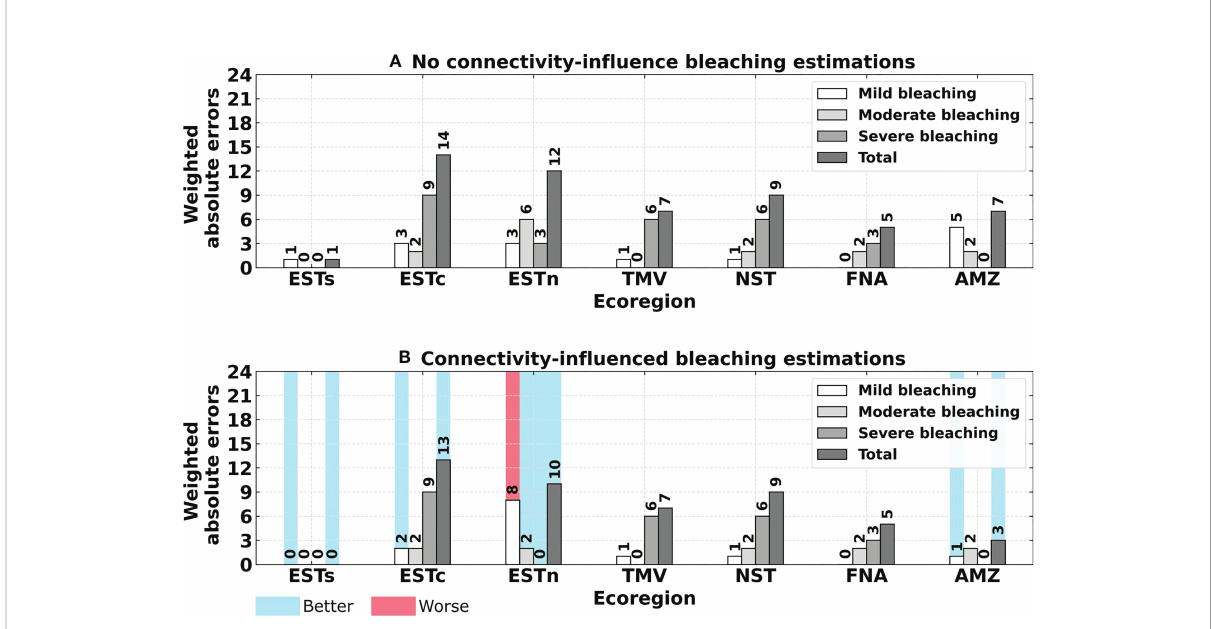
FIGURE 11 Absolute errors obtained for estimated bleaching events compared to reported bleaching events, as follows: (A) No connectivity-in fl uence estimated bleaching events; (B) Connectivity-in fl uenced estimated bleaching events. Values highlighted in blue and red indicate a better or worse bleaching estimate regarding the connectivity in fl uence, respectively. Ecoregions: Eastern-south (ESTs); Eastern-center (ESTc); Eastern- north (ESTn); Northeastern (NST), Amazon (AMZ), Fernando de Noronha-Atol das Rocas (FNA), Trindade-Martim Vaz Islands